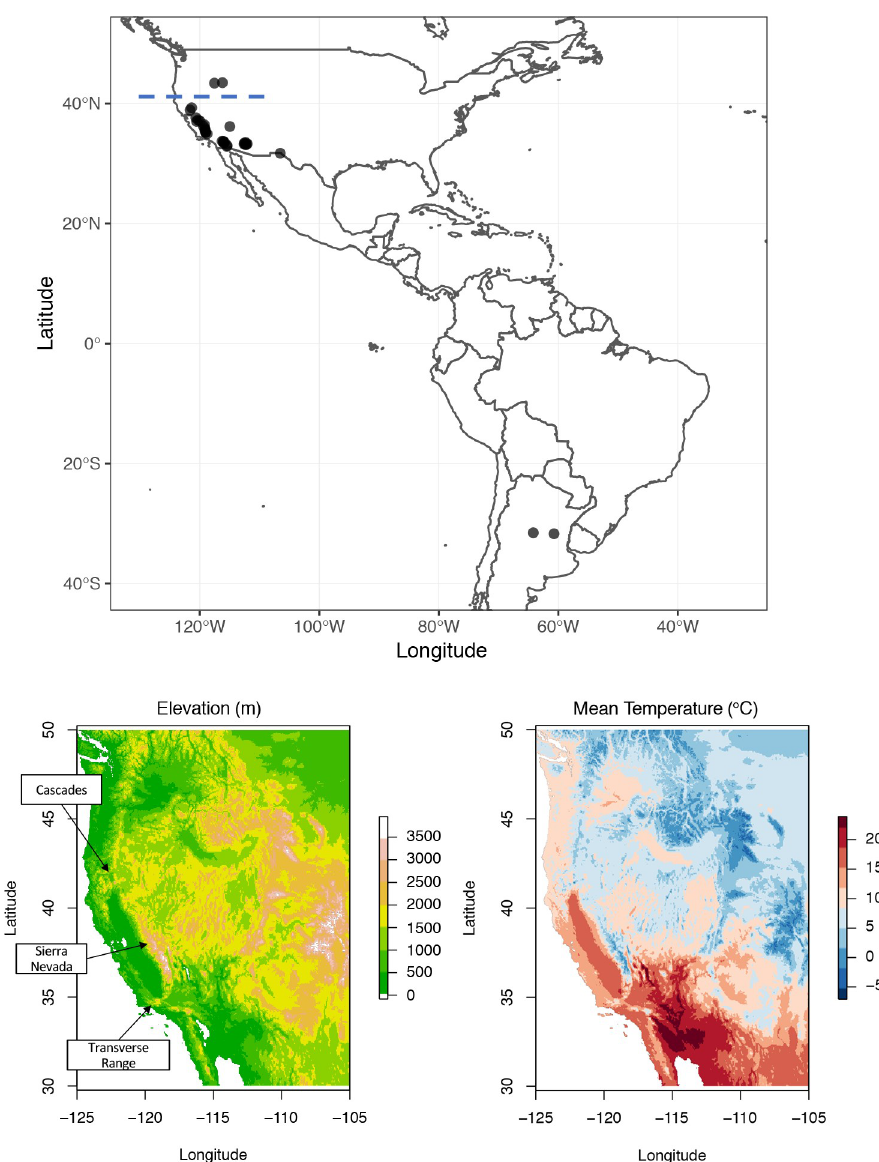
Fig 1. (A): Map of the Americas showing the distribution of genotype III St. Louis encephalitis virus genomes used in this study (circles). The 40˚N latitude line is shown by a blue hatched line. The varied landscape of the Western US is shown, including (B) elevation with several mountain ranges highlighted and annual mean temperature (C).